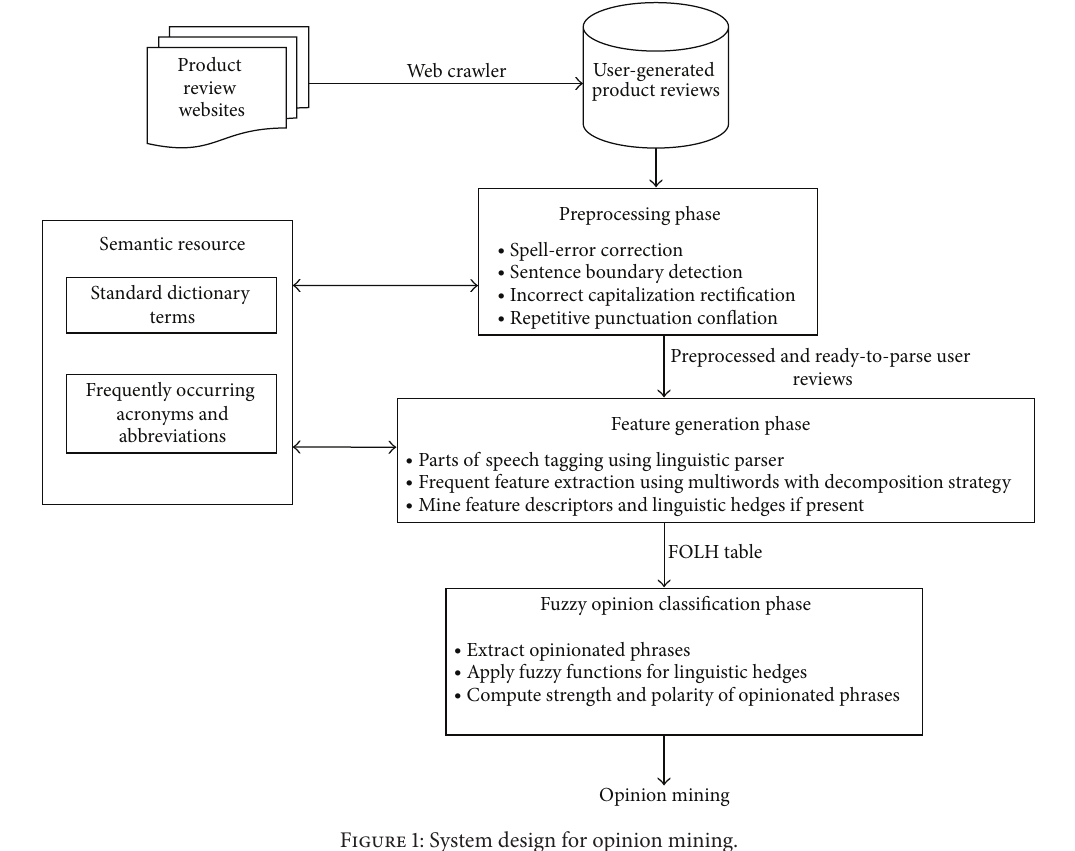
Figure 1: System design for opinion mining. Table 2: Partial feature orientation table with linguistic hedges for smartphone